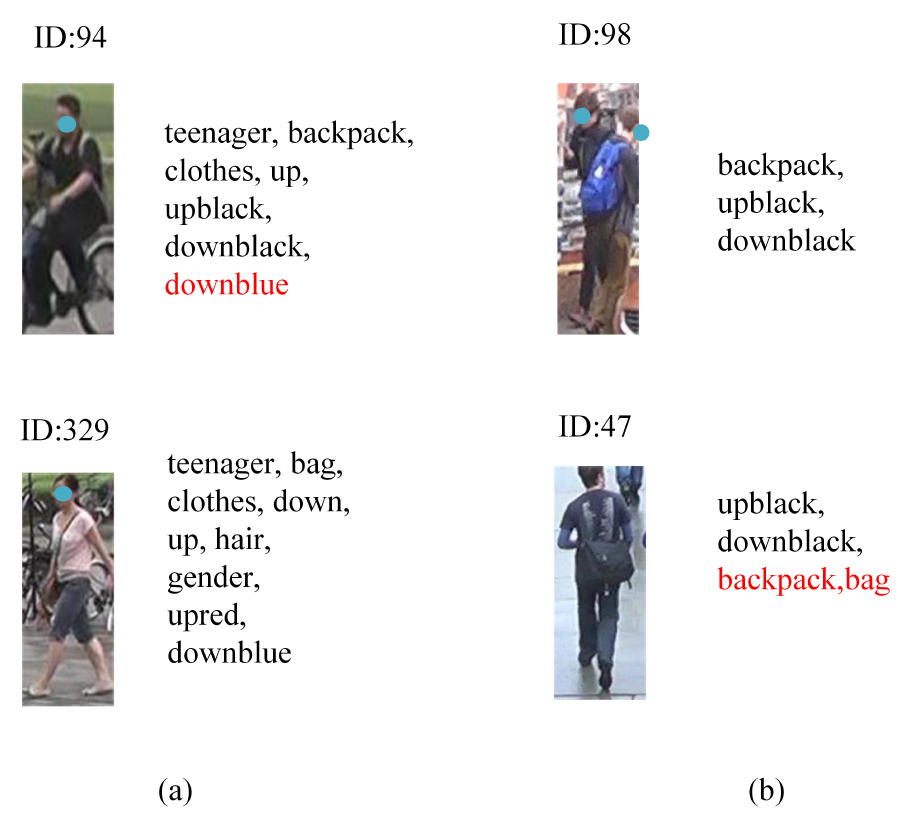
Figure 14. Attribute recognition results of proposed method. For each dataset, we list two examples, one positive and one negative. ( a ) Attribute recognition on Market-1501; ( b ) Attribute recognition on